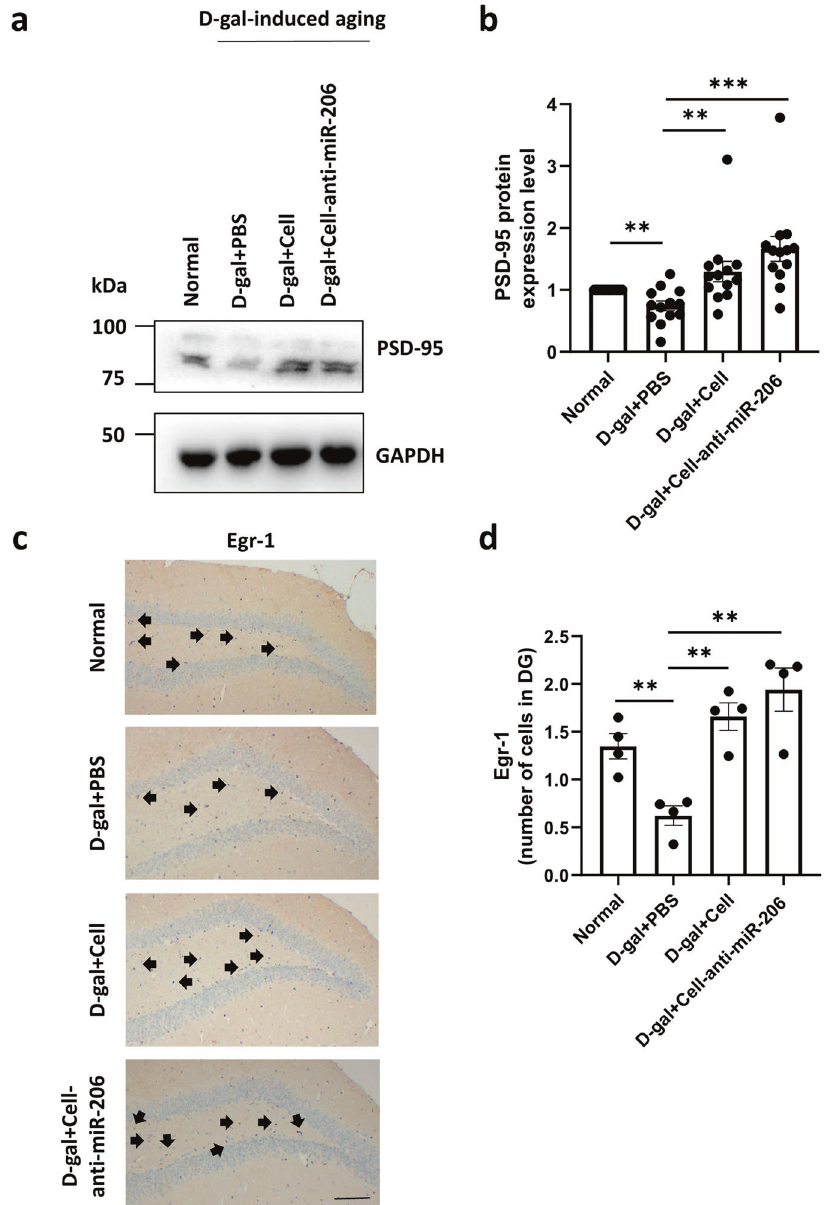
Fig. 7 The low expression of miR-206 of hUCMSCs promoted the expression of PSD-95 and Egr-1. a The protein levels of PSD-95 were determined by western blotting. b Quantitative analysis of the protein levels of PSD-95 and using ImageJ. c Egr-1 in the hippocampus was detected by immunohistochemistry, Bar = 50 µm. d Quantitative analysis of the protein levels of Egr-1 by ImageJ. The results were expressed as the Mean ± SD, * p < 0.05, versus D-gal + PBS groups ( n =